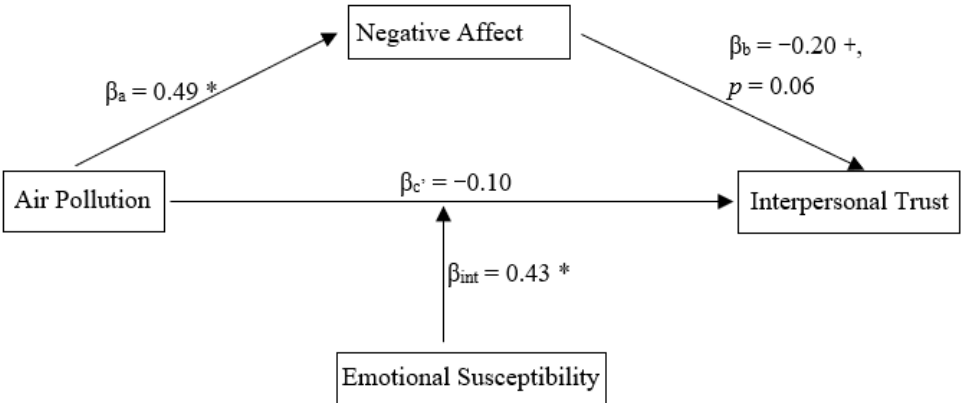
Figure 3. The overall research model. The relation between air pollution and interpersonal trust was mediated by negative affect and moderated by emotional susceptibility. + p = 0.06, * p < 0.05.